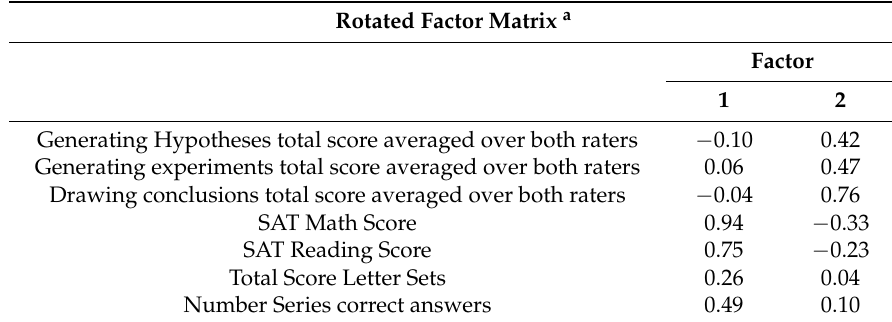
Table 8. Rotated maximum likelihood common factor matrix in the Study 1 factor analysis of the total scores of our subscales, the analytical ability tests, and SAT scores. Rotated Factor Matrix a Factor 1 2 Generating Hypotheses total score averaged over both raters − 0.10 0.42 Generating experiments total score averaged over both raters 0.06 0.47 Drawing conclusions total score averaged over both raters − 0.04 0.76 SAT Math Score 0.94 − 0.33 SAT Reading Score 0.75 − 0.23 Total Score Letter Sets 0.26 Number Series correct answers 0.49